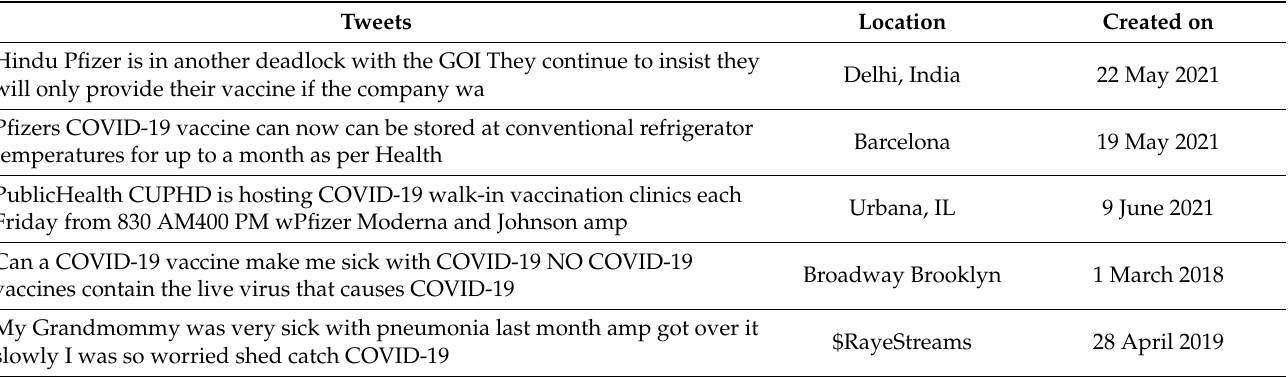
Table 7. Sample tweets (Corona Virus Tweet Dataset) with the corresponding location and date. Tweets